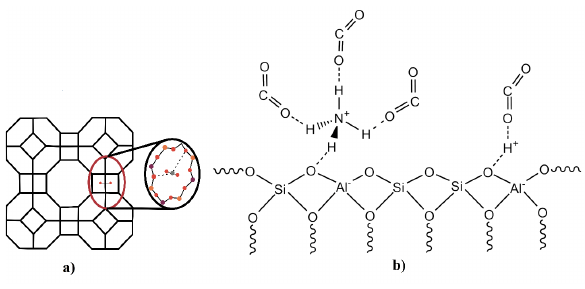
adsorption on pore and ANZ surfaces, 2